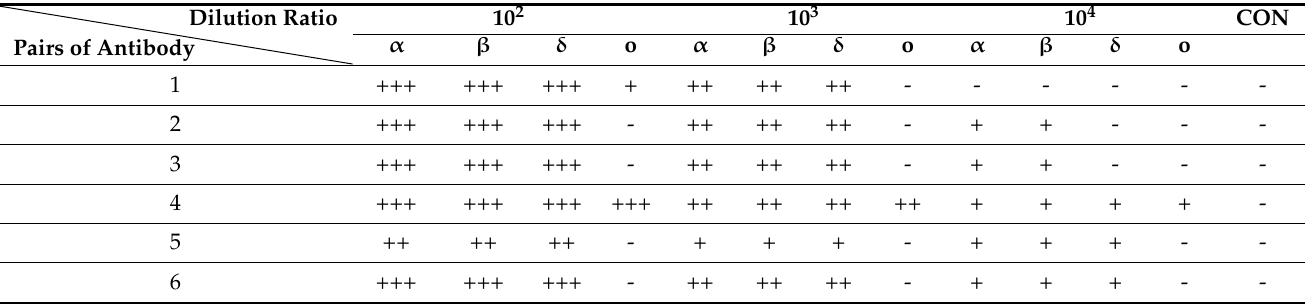
Table 3. Validation results of antibody pairs against the four strains. AntibodyDilution Pairs of